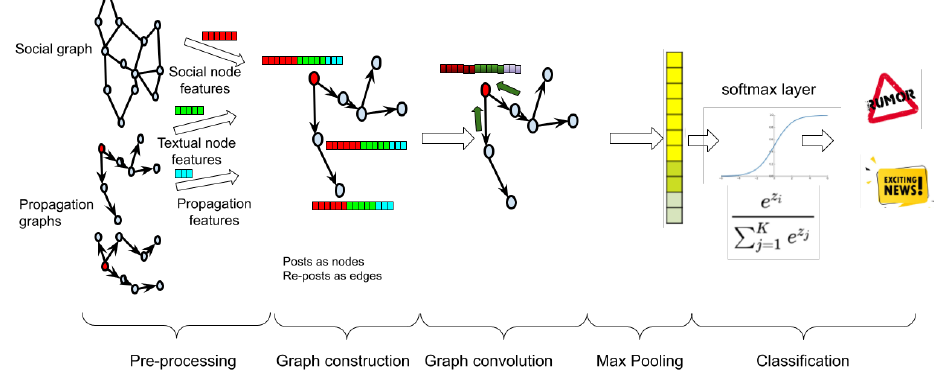
Figure 5. An overview of the rumor detection process using